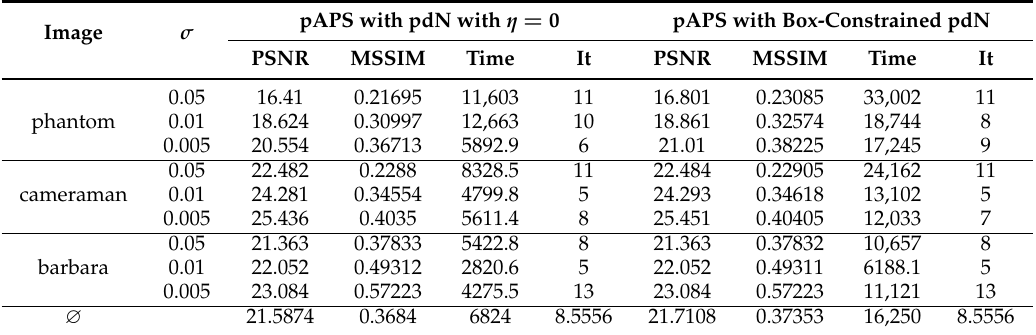
Table 10. PSNR- and MSSIM-values of the reconstruction of different images corrupted by Gaussian blur and Gaussian white noise via pAPS or pLATV using the primal-dual Newton method or via the ADMM by solving the constrained